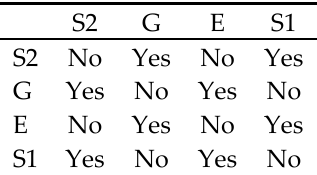
Table 3. Significant and non-significant differences in the pairwise comparison test using